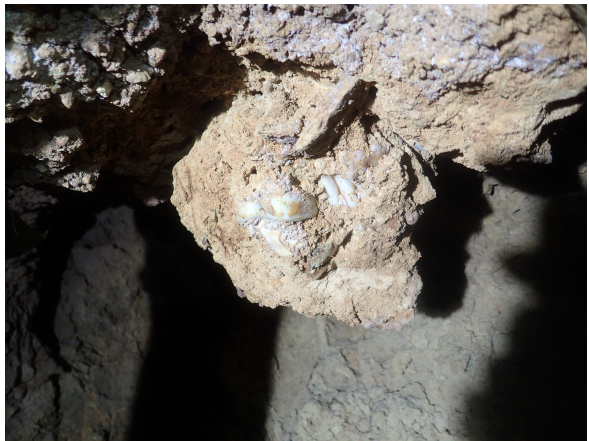
Figure 5. Fragment of osseous breccia from the Tham Hai Cave